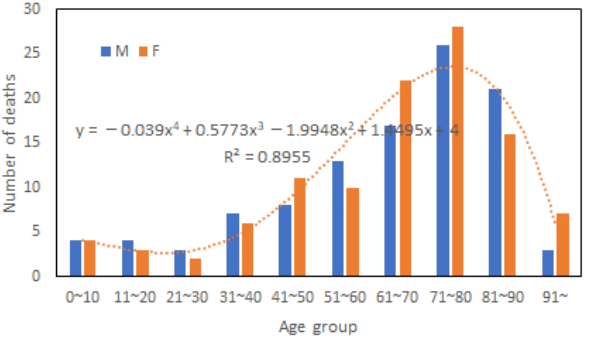
Figure 6. Death tolls in different age groups in 2018 (Data source: e-Stat, Japan).